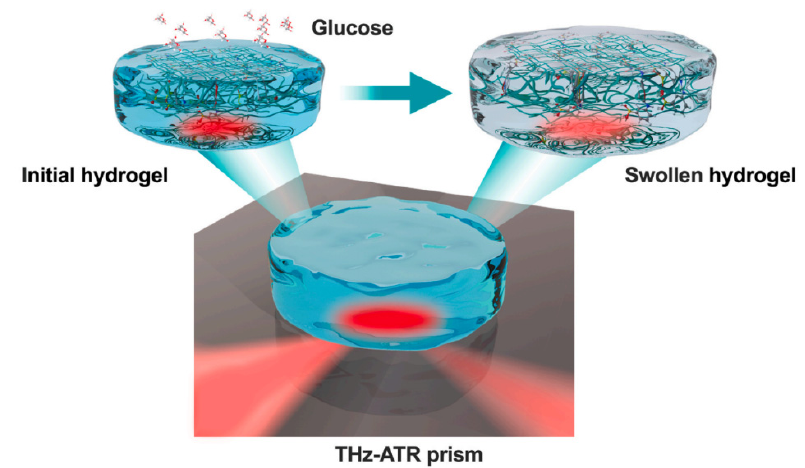
Figure 10. THz-ATR setup schematic with a smart hydrogel where the incident THz wave from the bottom left-hand side is propelled to the upper interface of the THz-ATR prism in the middle and then generates evanescent waves that penetrate the sample attached to the surface of the prism. The output reflected THz signal shown on the bottom right-hand side contains information about the permittivity of the sample. Hence, the complex permittivity of the samples can be obtained. Reprinted with permission from [45].